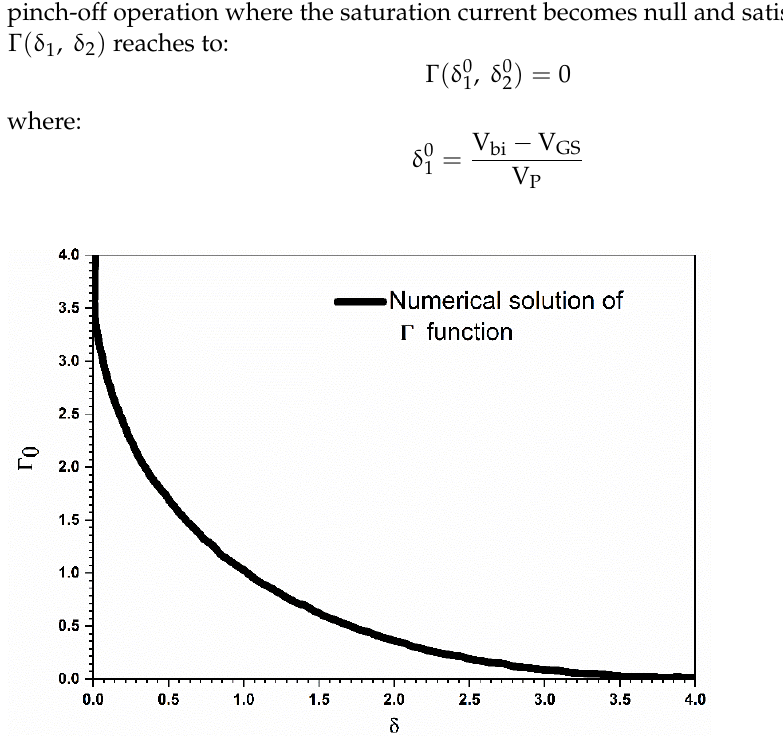
 which correspond to 0